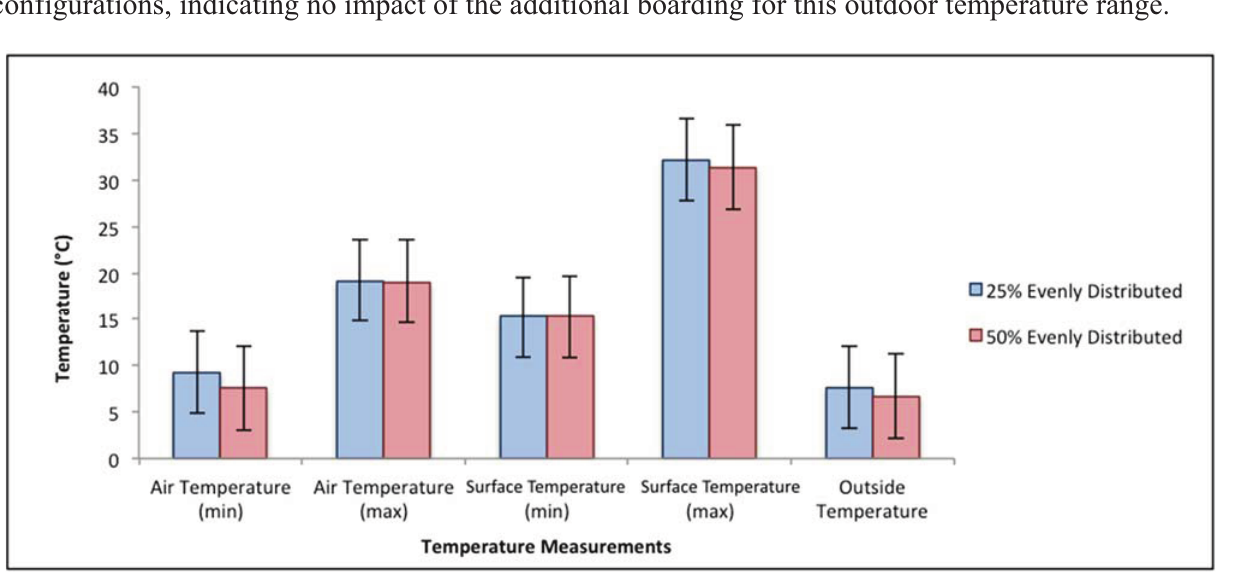
Figure 4. Effects of additional boarding beyond TQA guidelines (50% vs. 25% for outdoor temperature range 4–9 °C (40–49 °F), n = 3) on maximum and minimum observations for zone-centered air temperature and pig surface temperature. Error bars were included to indicate the standard deviations for each